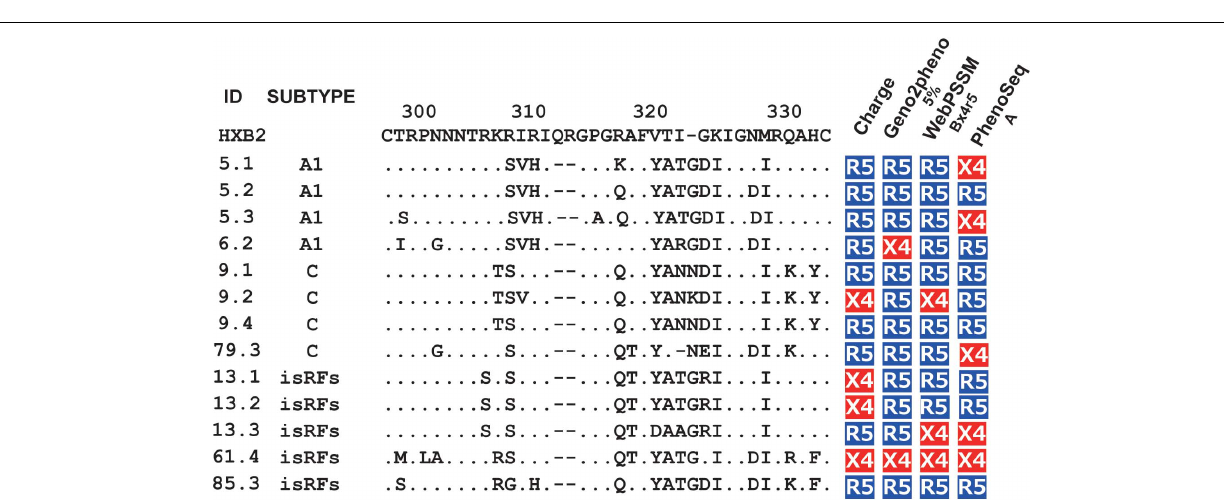
FIGURE 2 | Genotypic prediction of the phenotypic R5X4 clones. Amino acid sequences of V3 region and co-receptor assignment by genotypic analysis of the phenotypic R5X4 clones ( n = 13). Coreceptor tropism was predicted by V3 net charge, Geno2Pheno [5%], WebPSSM [Bx4r5], and PhenoSeq [A]. The resultant genotype results are shown as R5 (in blue) and X4 (in